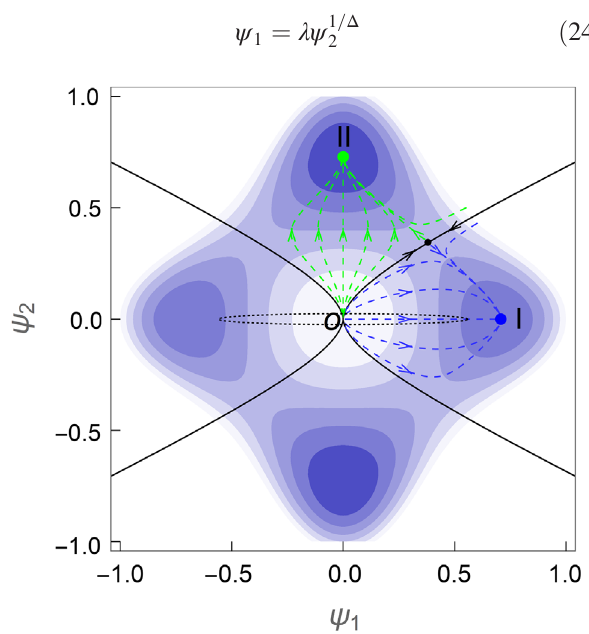
FIG. 4. Basins of attraction of the two orders on the contour plot of the free-energy landscape. Lower energy appears bluer. The arrows show the direction of order parameter dynamics. Black solid line separates the basins. The parameters used are ð α 1 L ; α 2 L Þ ¼ ð 1 . 0 ; 1 . 1 Þ , ð γ 1 ; γ 2 Þ ¼ ð 2 ; 1 Þ ps − 1 , and c ¼ 6 . Black dotted line illustrates the magnitudes of ψ fluctuations at time i t ¼ 2 . 0 ps for G 1 ¼ G 2 ¼ 10 − 4 and spatial dimension D ¼ 3 . Most of the probability lies in the basin of order I, meaning most volume of the system will be trapped into I